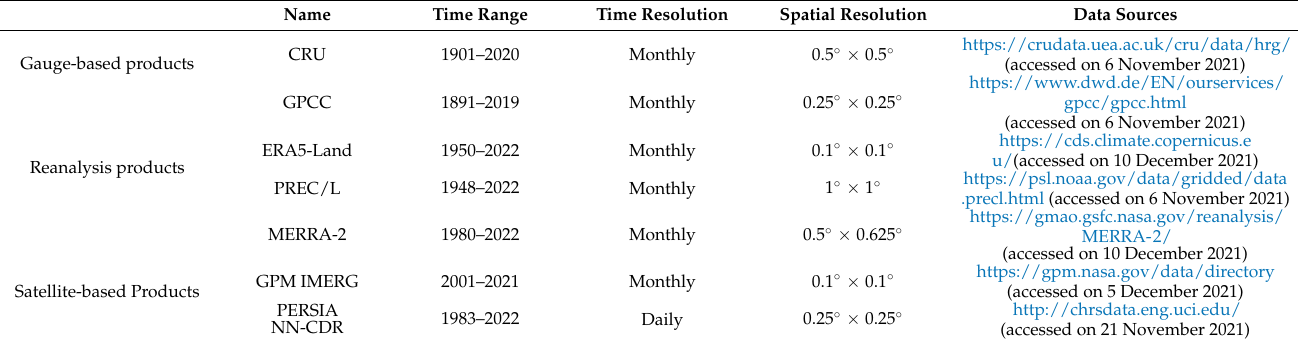
Table 1. Information about the seven gridded precipitation products used in this